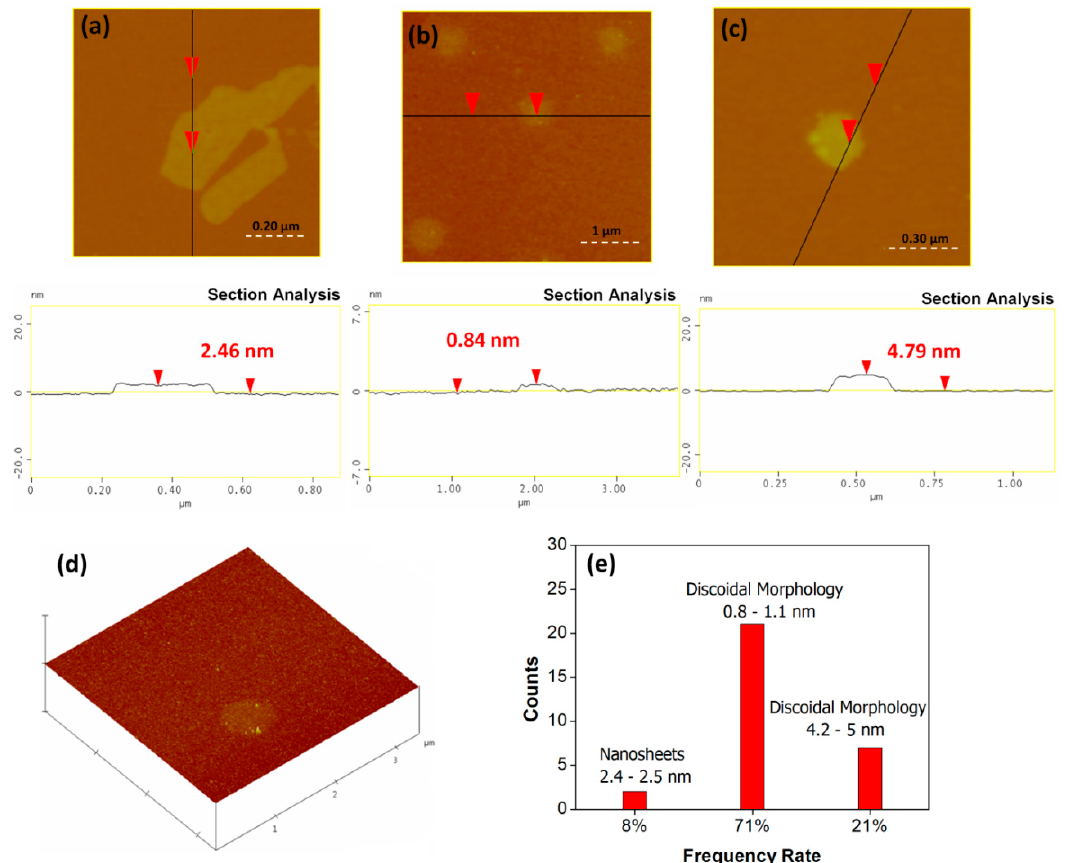
Figure 6. ( a – c ) AFM images of cross-sectional analysis of the carbon sample (nanosheets and discs). ( d ) 3D morphology of a flat disc. ( e ) Histogram of frequency rate of the different morphologies along with their thicknesses.